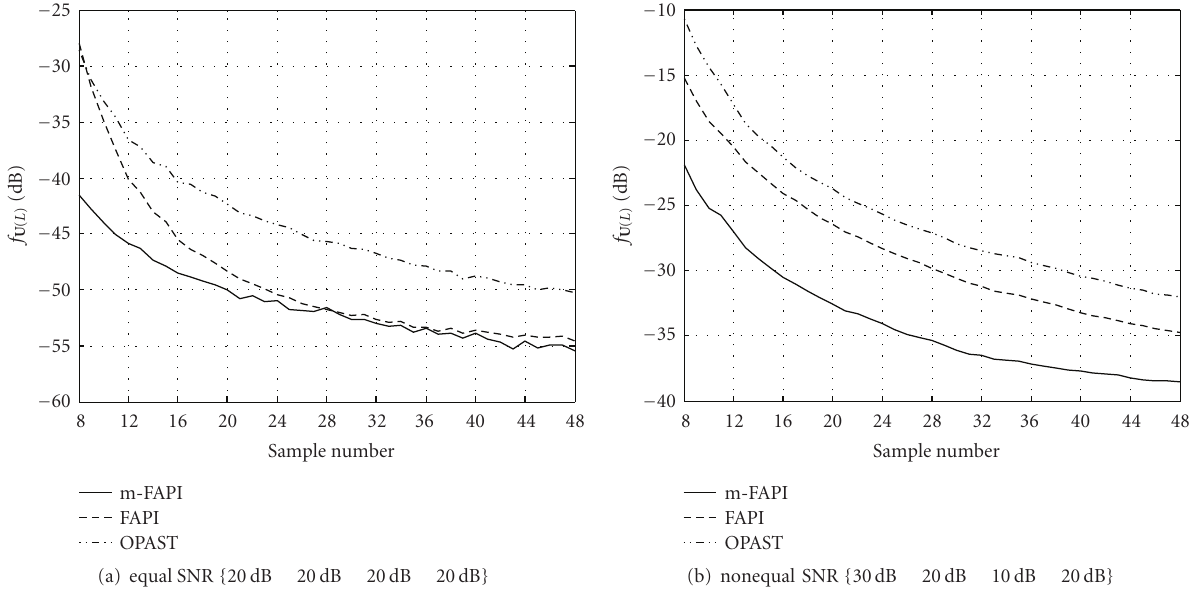
Figure 2: The estimation error f U ( L ) versus sample number with M = 11 and P = 4.